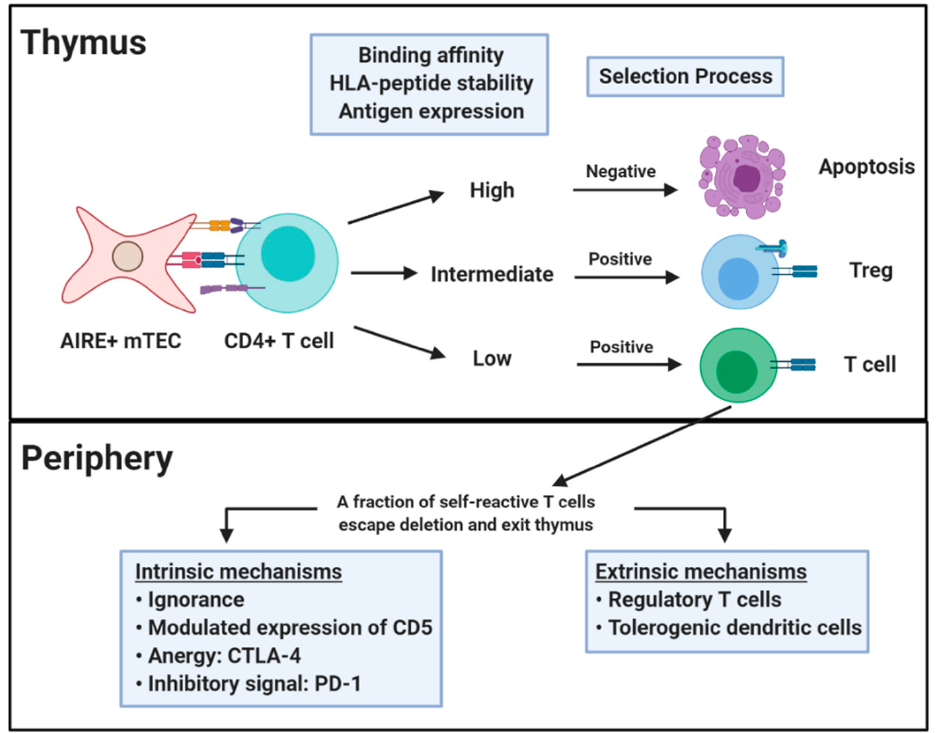
Figure 1. Central and peripheral tolerance. Central tolerance occurs in the thymus and relies on self-antigen expression on medullary thymic epithelial cells (mTEC) under regulation of the transcription factor AIRE. CD4 + T cells that recognize self-antigens in the context of HLA class II proteins undergo positive or negative selection. The selection process is based on the nature of the interaction between TCR and HLA-peptide complex. T cells that are positively selected go on to populate the periphery where they are controlled by peripheral tolerance mechanisms acting directly on the self-reactive T cells (intrinsic) or indirectly via additional cells (extrinsic). Figure created with BioRender.com.